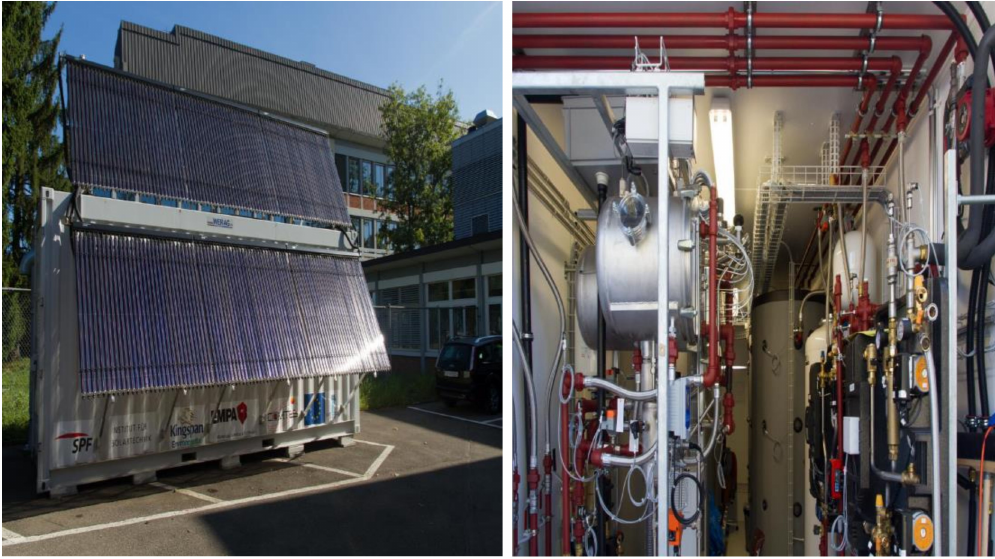
Figure 19. Prototype of closed sorption storage system